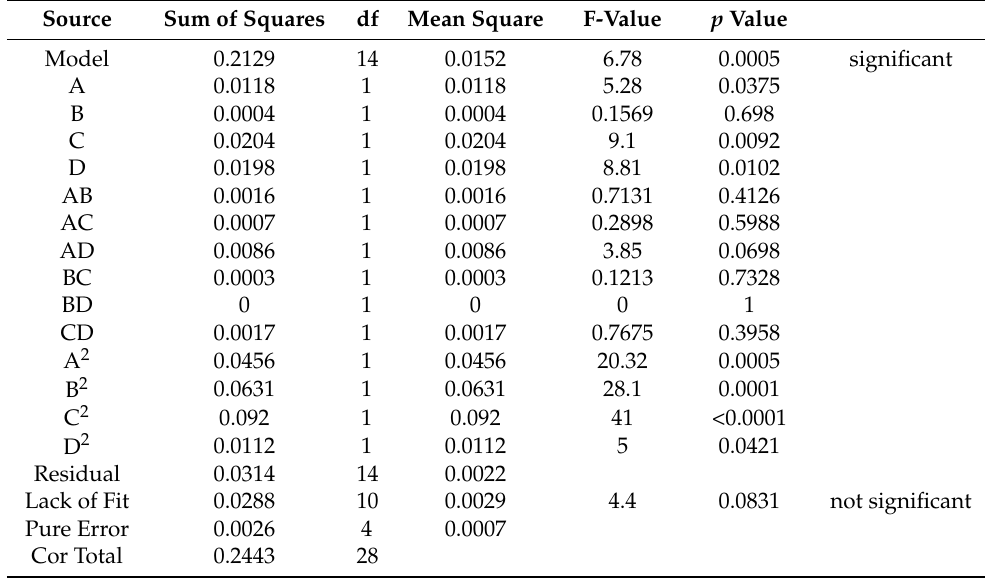
Table 5. Analysis of variance (ANOVA) results for relaxed